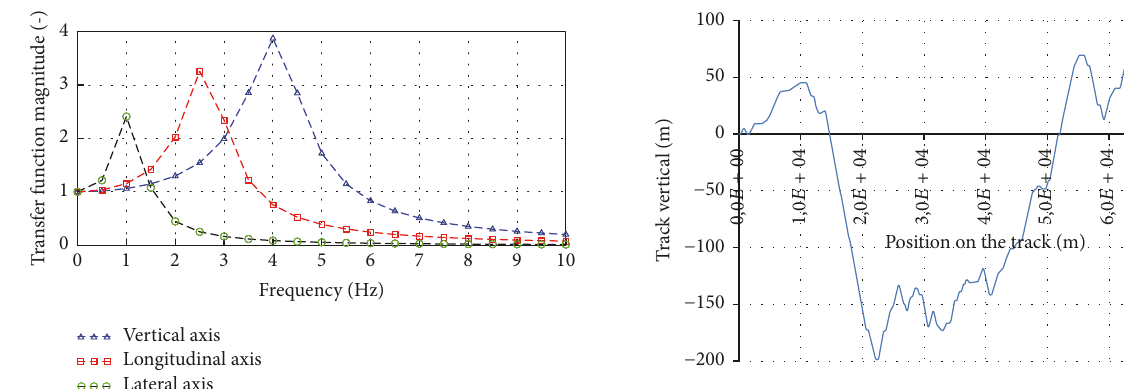
Figure 17: Layout of the track in the vertical